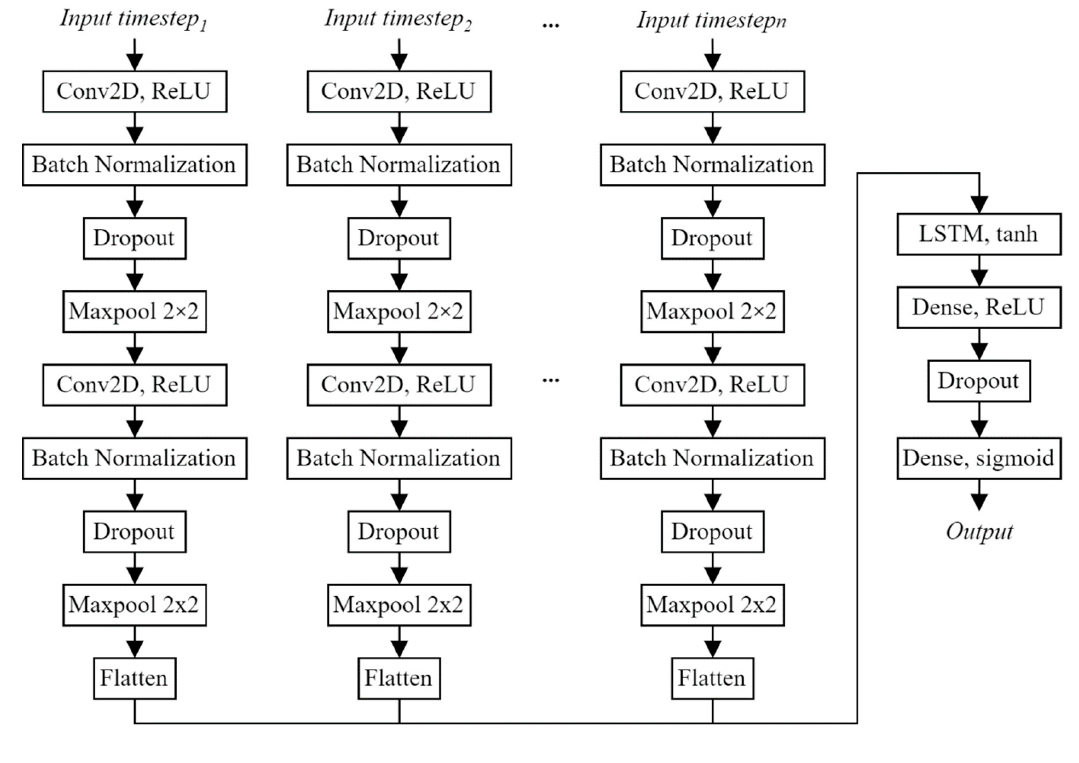
Figure 3. Proposed CNN-LSTM method architecture [30].